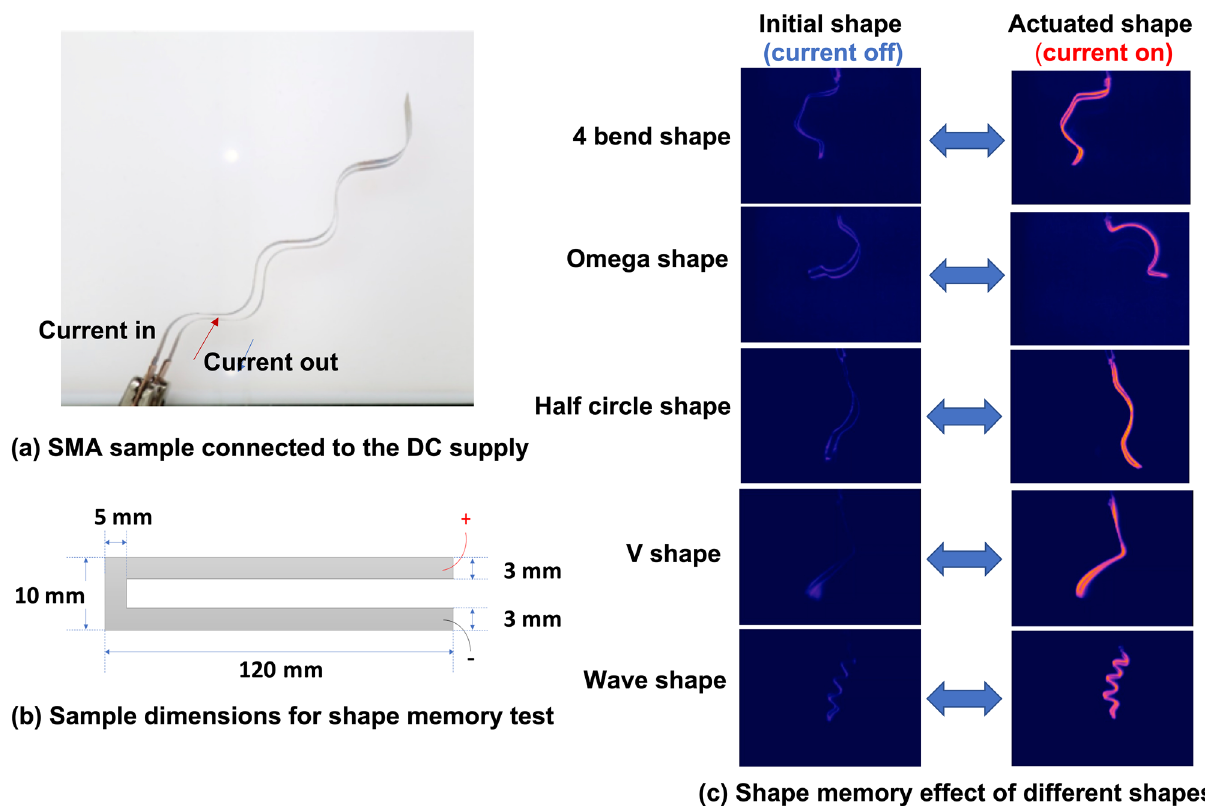
Figure 2. (a) Two legs of SMA connected to the DC supply; (b) the sample dimension of SMA used in this study; (3) thermal images of the initial and actuated shape of the five different SMA bodies that were used in this study. The changes in shape and position during electrical excitement were the key dynamic information captured through the video imaging. The captured information was correlated with the measured force and stress to develop a predictive machine learning